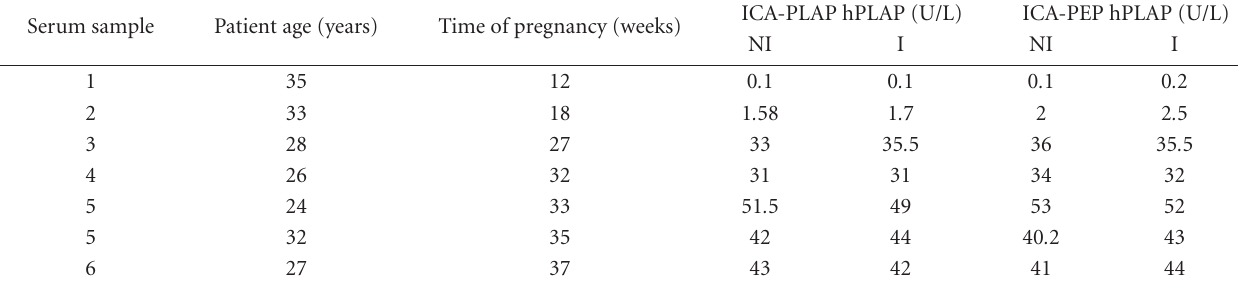
Table 1: hPLAP activities in noninactivated (NI) and heat-inactivated (I) pregnant serum measured by ICA-PLAP and ICA-PEP. Serum